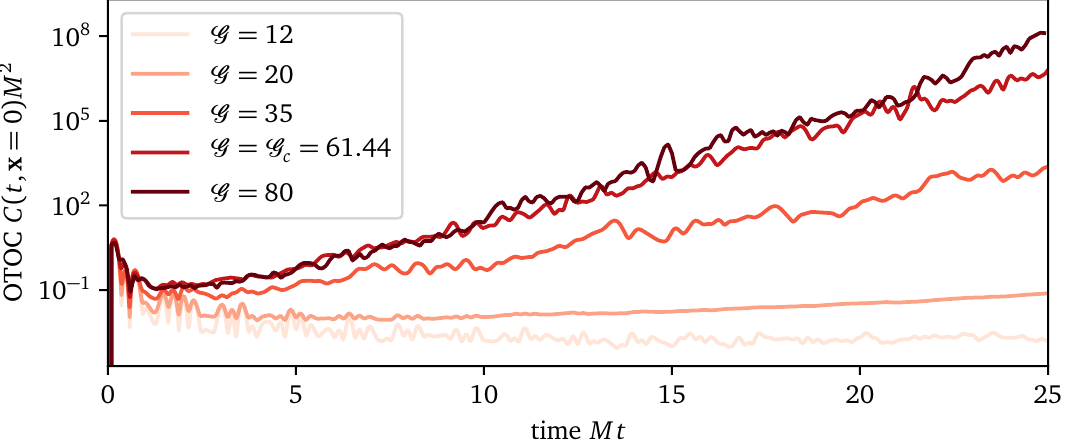
Figure 3: Local OTOC. After the trivial short-time dynamics related to the spreading of a sharply peaked momentum-field perturbation, chaotic exponential growth sets in with late time behaviour dominated by the largest Lyapunov exponent, which is strongly dependent on the value of the fluctuation parameter G . For the smallest value G = 12, exponential growth only sets in after the time scale shown here; we hence evolved larger systems to longer times to determine the Lyapunov exponent in that